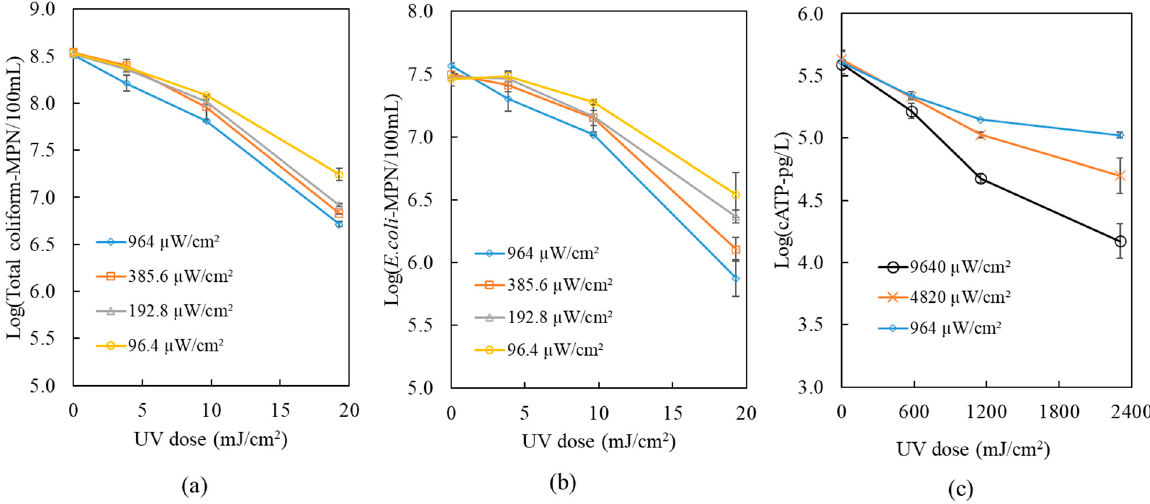
Figure 5. Disinfection of secondary wastewater effluent by a 280 nm LED: ( a ) total coliform log reduction, ( b ) E. coli log reduction and ( c ) cATP reduction. Table 3. Summary of the UV dose required for one log reduction of different parameters.